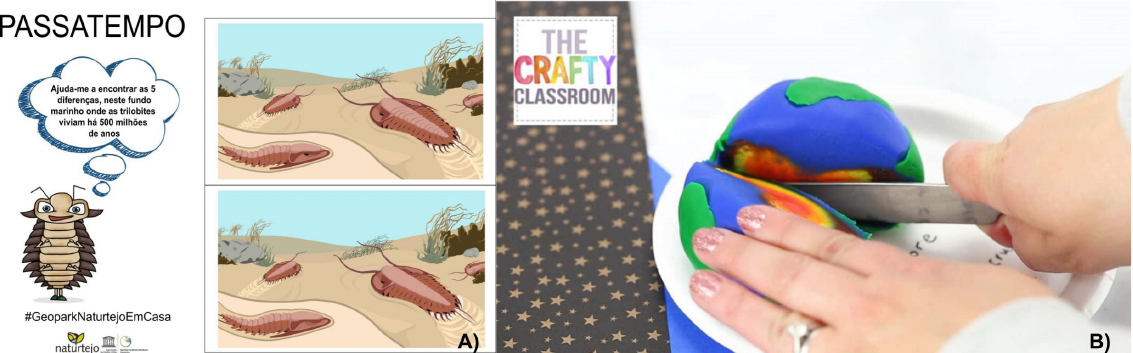
Figure 7. Examples of play and craft activities in UNESCO Global Geoparks. A) Play activities from the Naturtejo Geopark website (https://www.naturtejo.com/) and B) craft activity from the Marble Arch Caves Geopark website (https://www.mar-